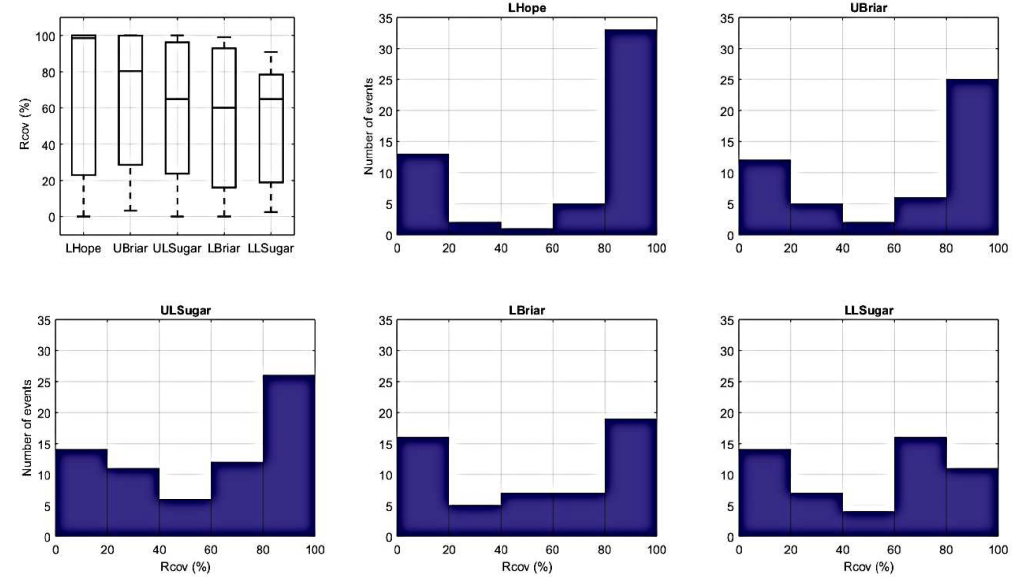
Figure 3. Box plots showing 10, 25, 50, 75 and 90% quantiles (a) and empirical histograms (b) of fractional basin coverage by maximum rainfall intensities >25mmh − 1 , representative of the storm core, for the five basins in the Little Sugar Creek catchment.